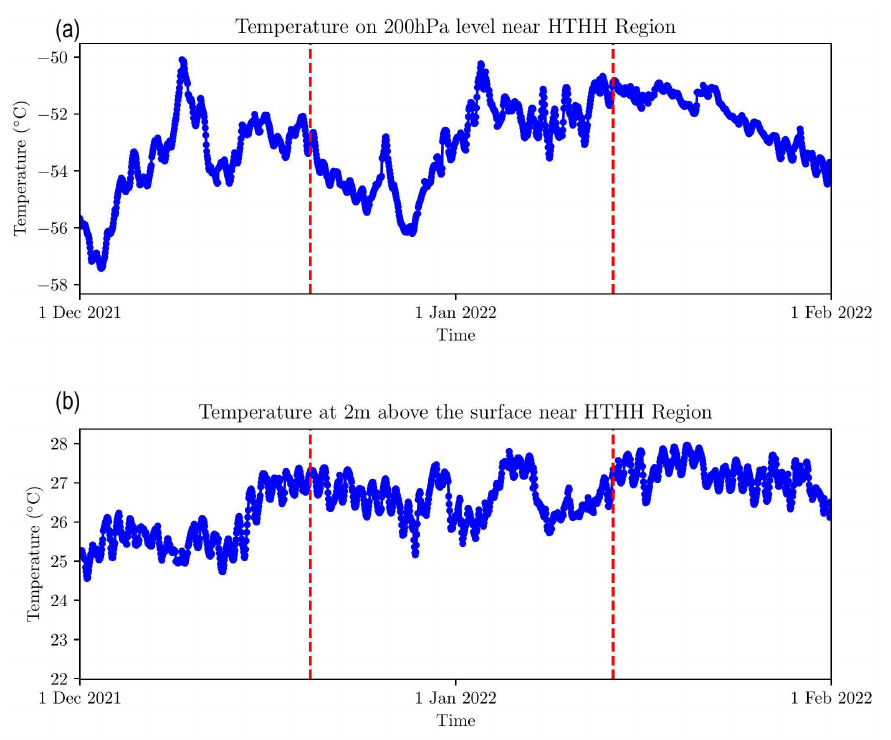
Figure 2. The average temperature series at ( a ) 200 hPa and ( b ) 2 m around the HTHH. The averaged region is centered at the eruption location (20.54 ◦ S, 175.38 ◦ W) and extends from 177.88 ◦ W to 172.88 ◦ W and from 23.04 ◦ S to 18.04 ◦ S. The start dates (20 December 2021 and 13 January 2022) of the two dominant eruptions of the HTHH are highlighted by two dashed vertical red